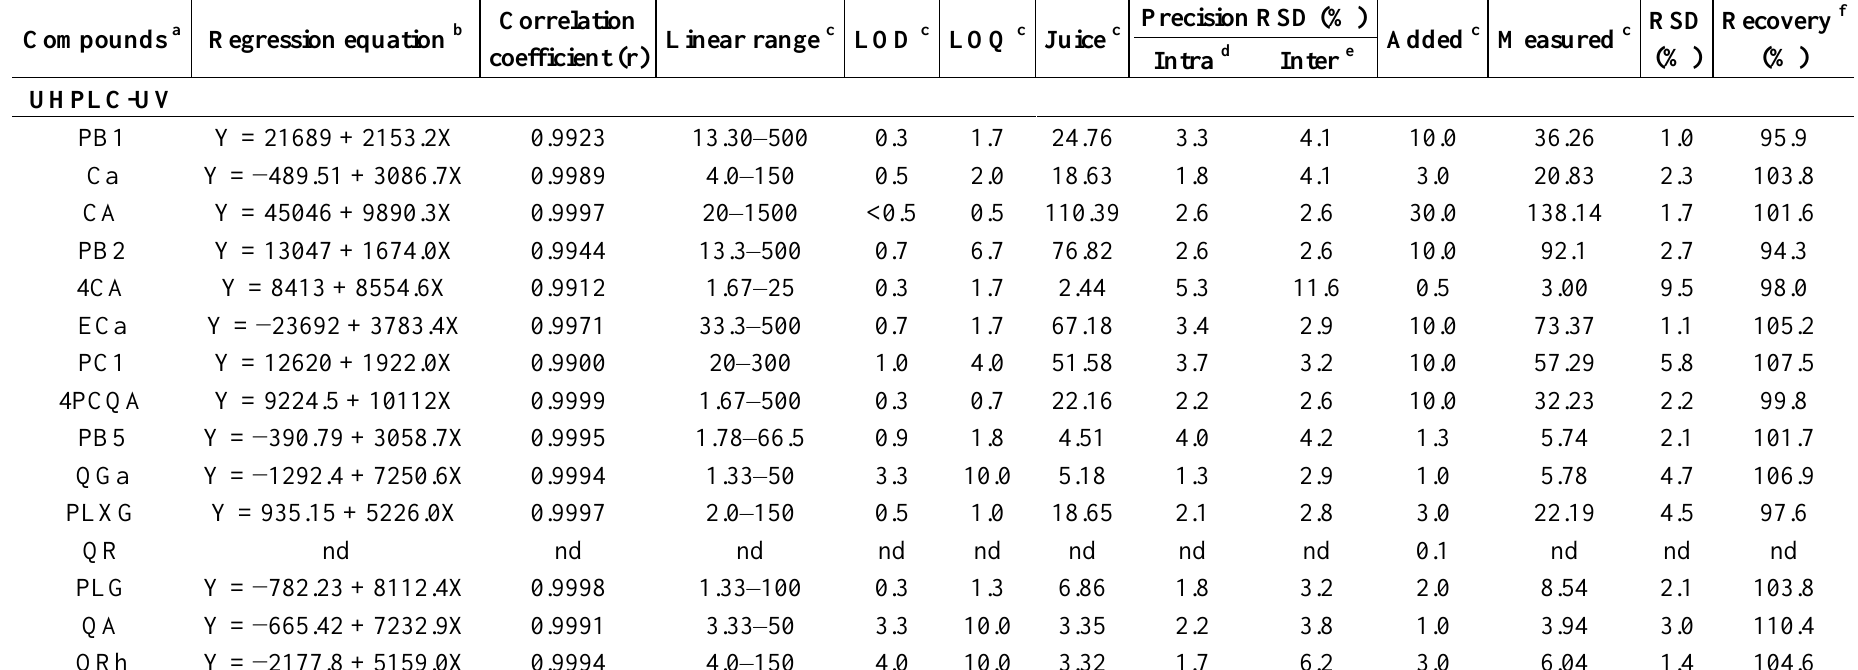
Table 1. Calibration curve parameters for the 15 major phenolic compounds according to UV detection and results of the validation study for P12R3A28 apple